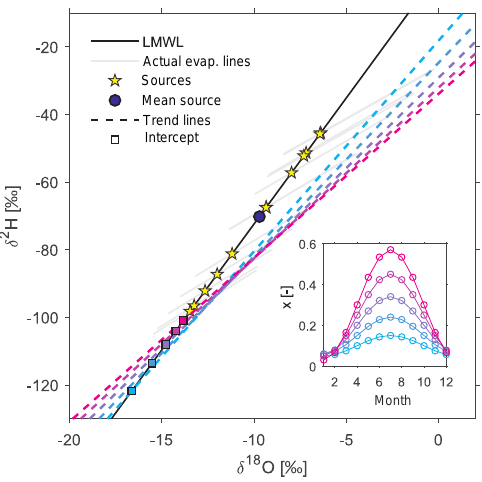
Figure 6. Hysteretic pattern arising in the computed residual liquid when the seasonality of evaporation rates is shifted relative to the seasonality of the source water composition (see